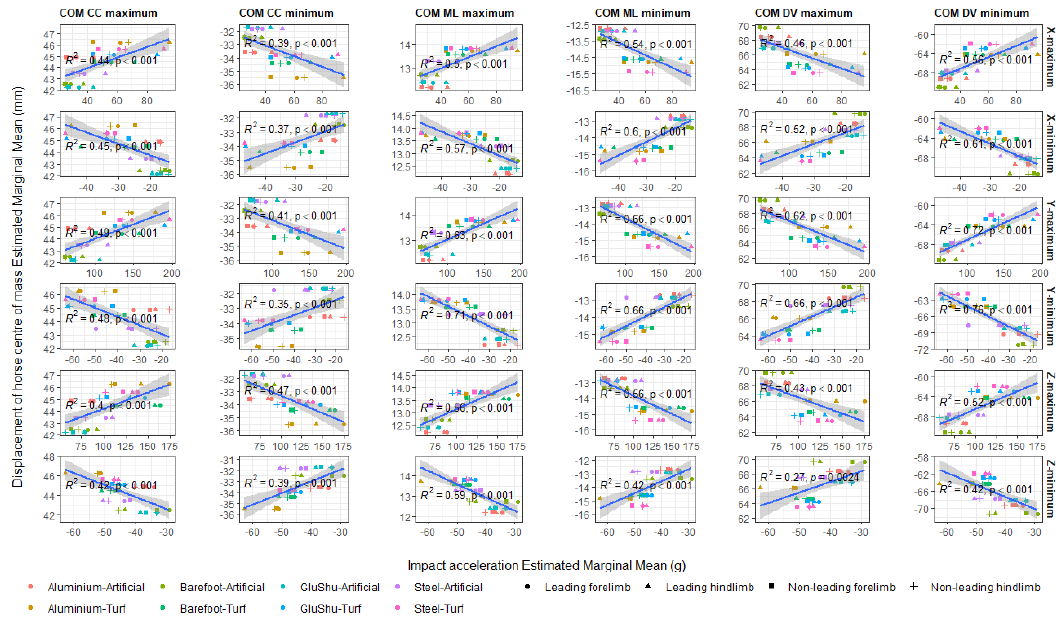
Figure A7. Relationship between impact acceleration data and centre of mass (COM) displacements. Data are subdivided horizontally by the hoof acceleration parameters (x-maximum, x-minimum, y-maximum, y-minimum, z-maximum and z-minimum) and vertically by the COM parameters (CC-maximum, CC-minimum, ML-maximum, ML-minimum, DV-maximum and DV-minimum), as indicated by the labels on the right and top sides of this figure. Within each subplot, the data are further subdivided according to both shoe–surface combination and limb.